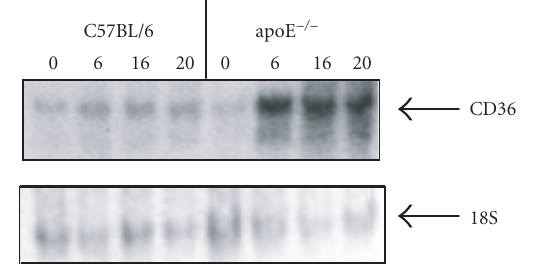
(a) Representative Northern blot showing CD36 mRNA levels in testis ofchowfedapoE − / − mice,incomparisontowildtype(C57BL/6).Blots contained 20 µ g of total RNA. The 0, 6, 16, and 20 correspond to the number of weeks of chow diet. The 18S expression served as a control for loading and for quantification.